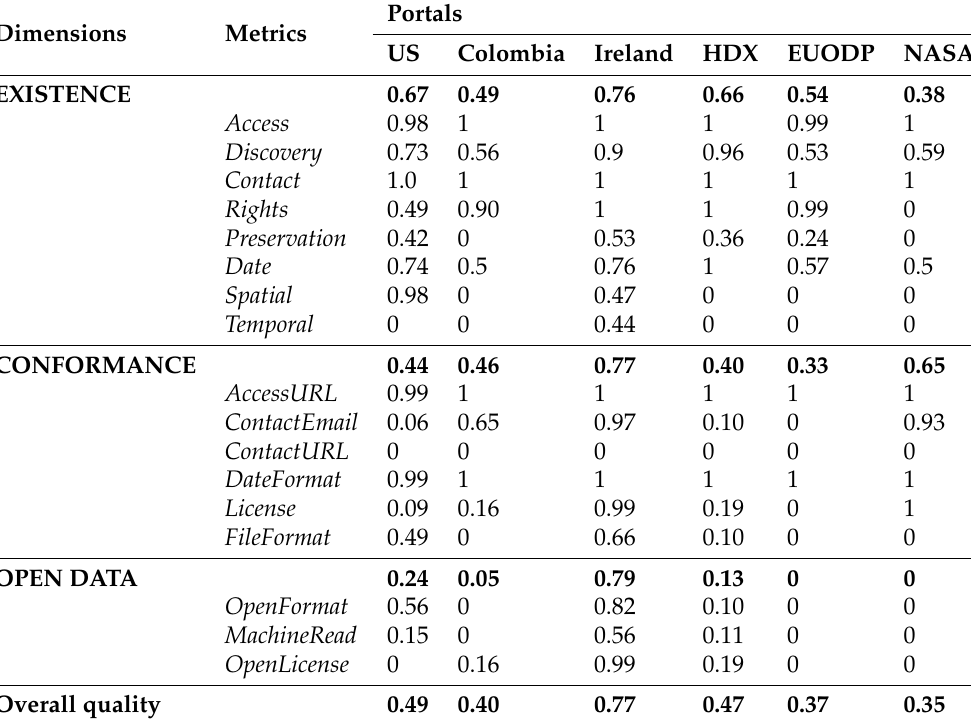
Table 5. Mean values of metadata quality dimensions (in bold) and metrics for the six OGD portals. We followed the nomenclature in Neumaier et al. [14] for dimensions and metrics names, except for Spatial and Temporal , declared and implemented only in the framework code. The last row reports the means overall quality for each